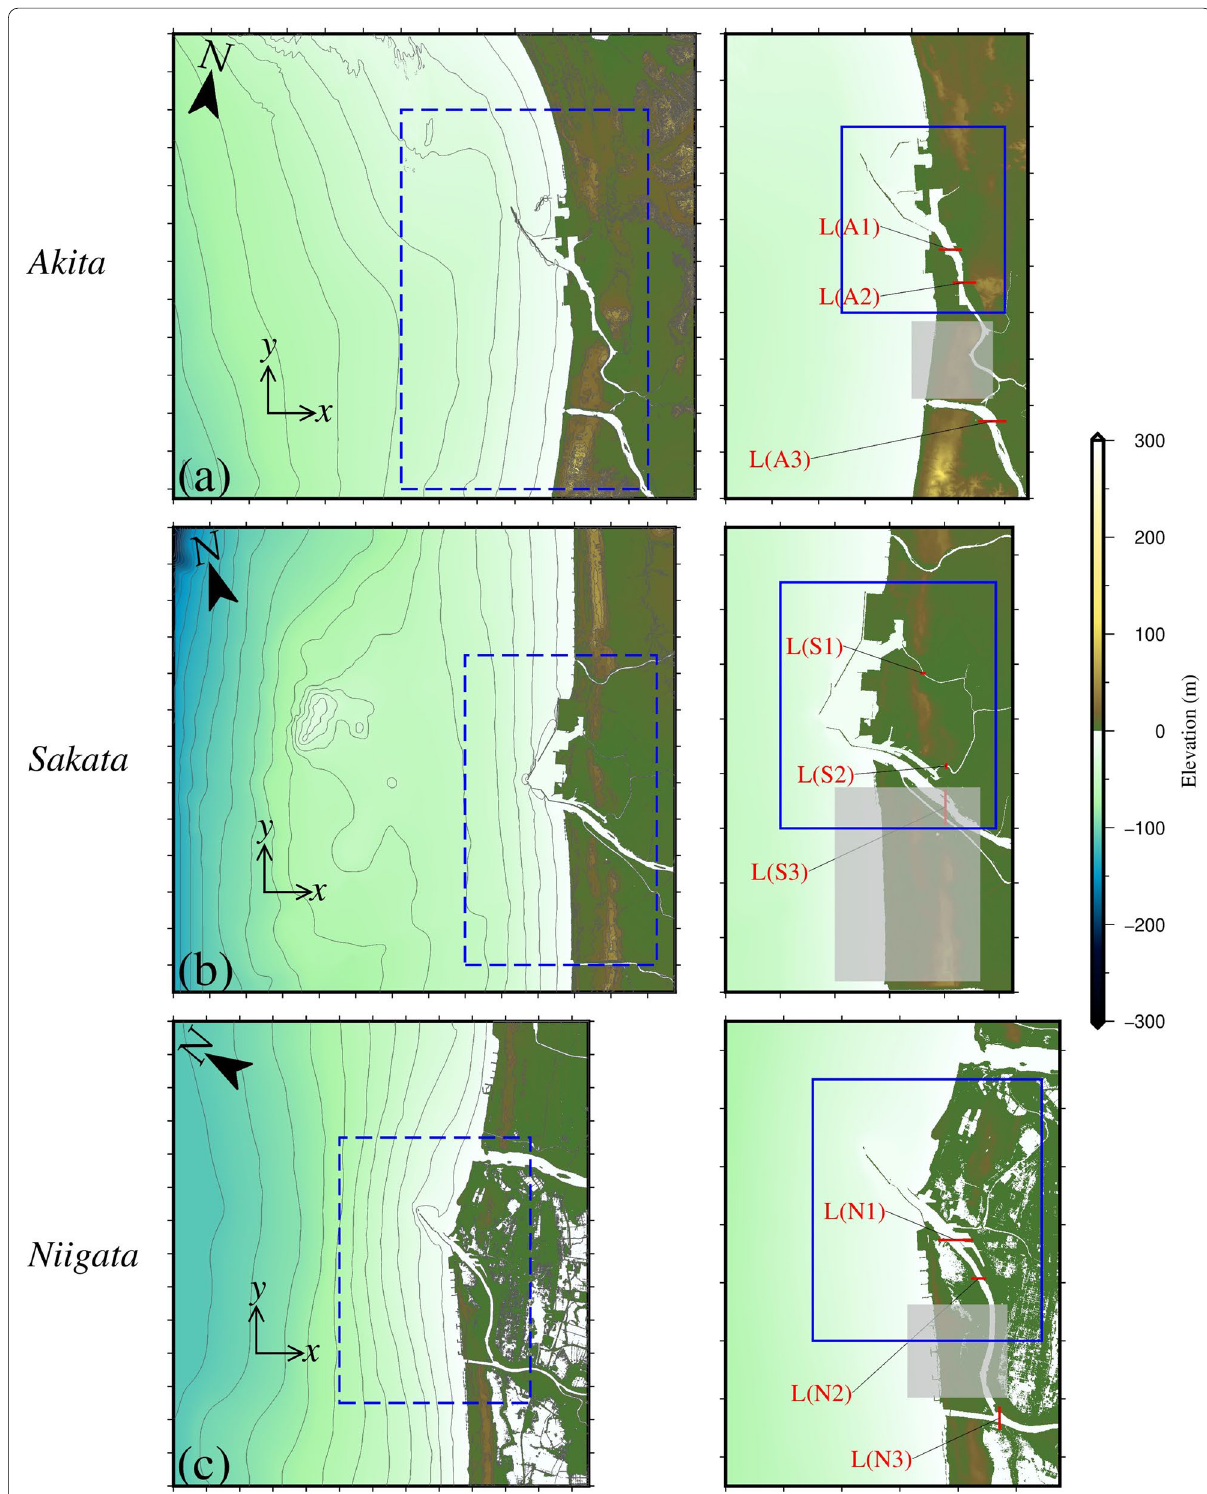
Fig. 3 Geometries in the targeted areas. a Akita City; b Sakata City; c Niigata City. Each panel on the left side corresponds to the area for the inundation simulation, and that on the right side displays a magnified view of the area specified by the blue dashed square in the left. The tick interval was 2 km for all the panels; the interval of contour lines in the left panels was 10 m; the red lines are a cross-sectional slice for rivers and gray areas are control areas for dunes in the left